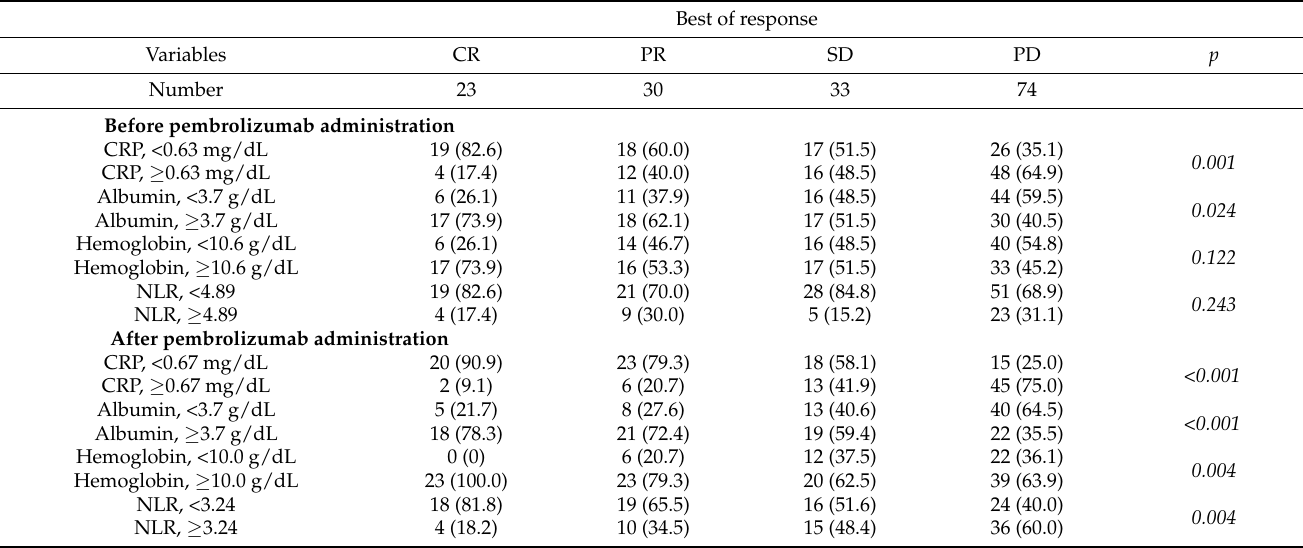
Table 3. Changes in CRP, Albumin, Hemoglobin, and NLR levels, before and after pembrolizumab